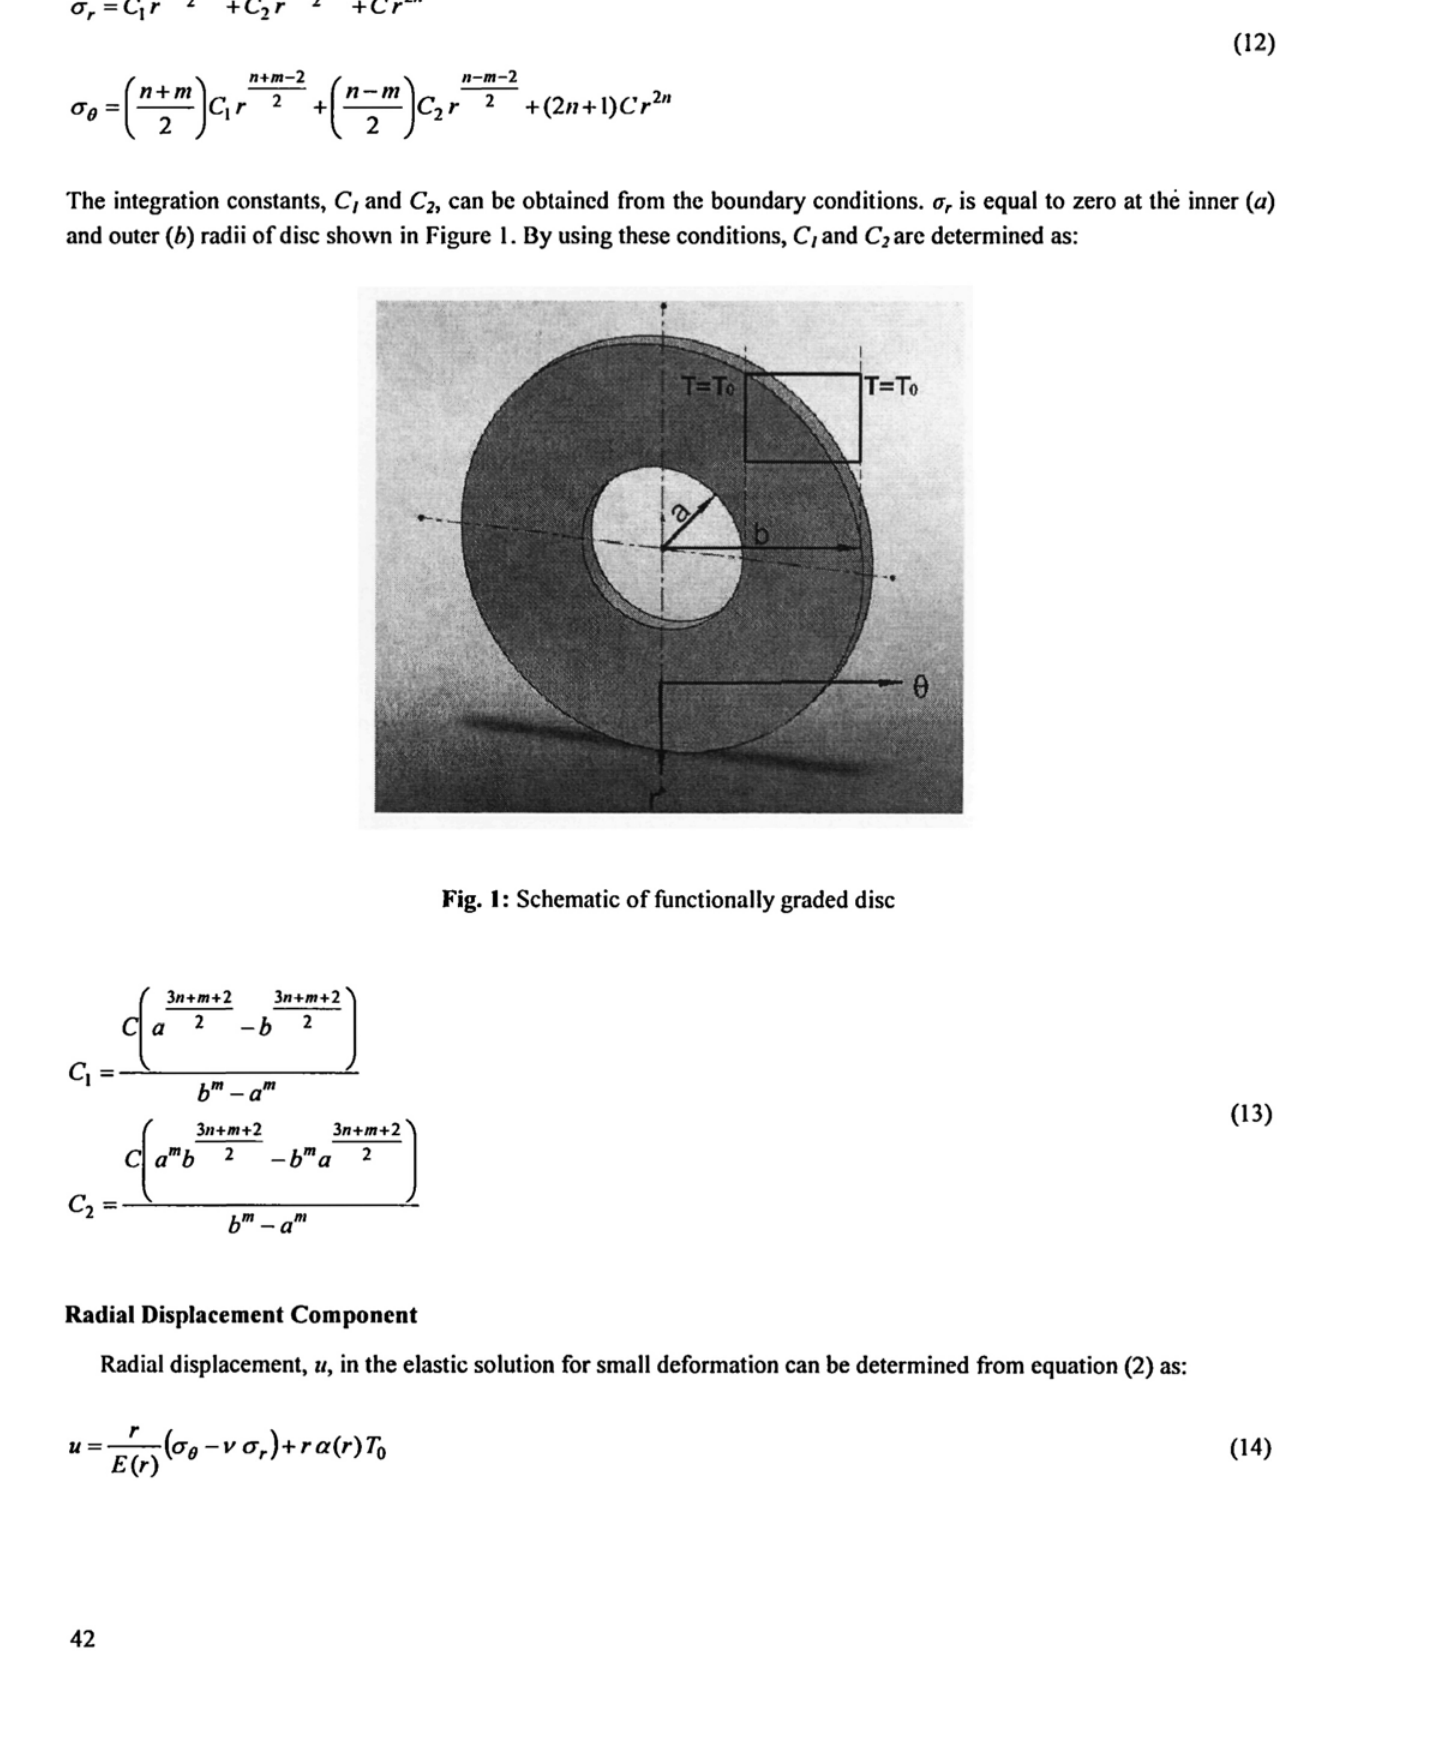
Fig. 1: Schematic of functionally graded